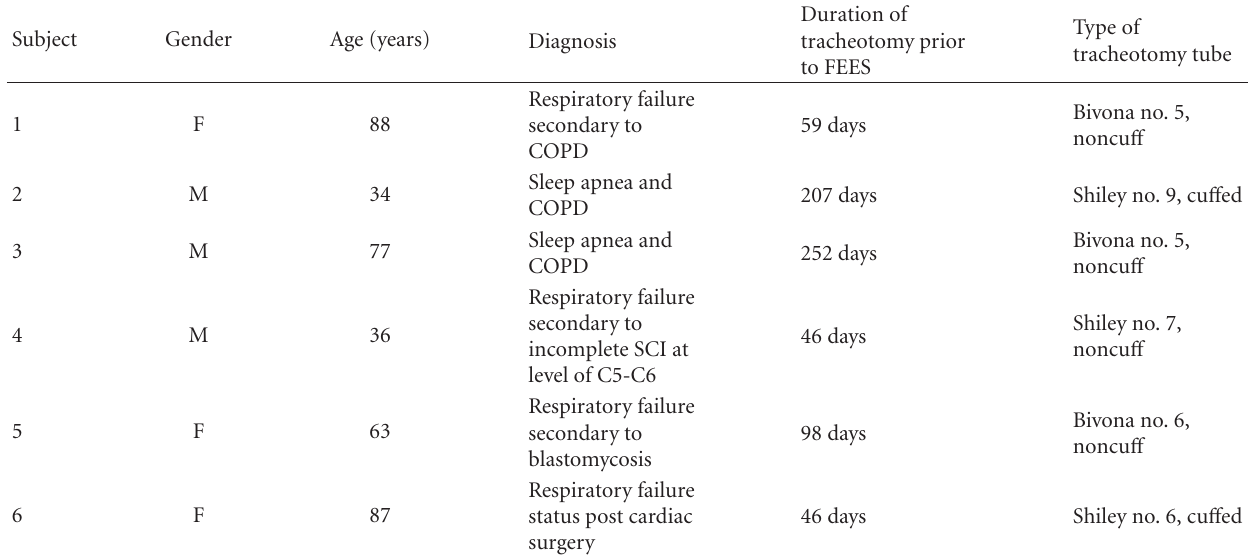
Table 1: Subject demographics.